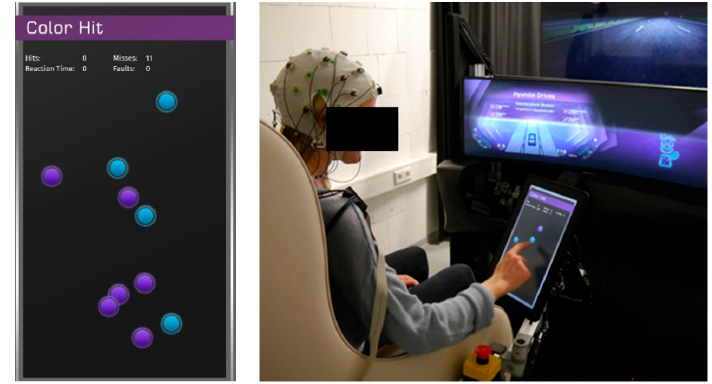
Figure 1. Screenshot of the sleep inertia counter-procedure for drivers (SICD, left ) and participant equipped with EEG electrodes performing the SICD ( right ).